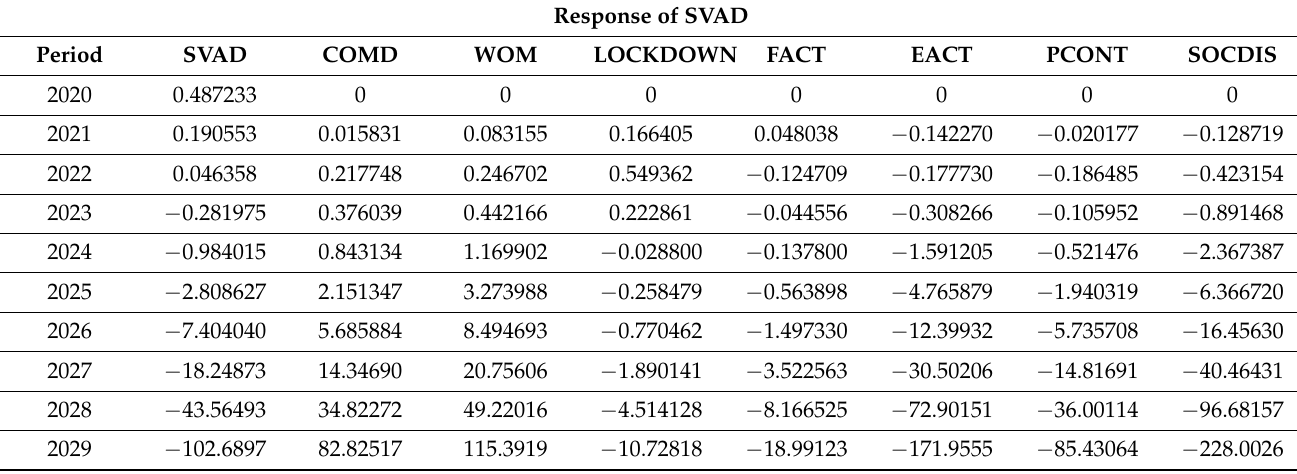
Table 7. Impulse Response Function (IRF) Estimates. Response of SVAD